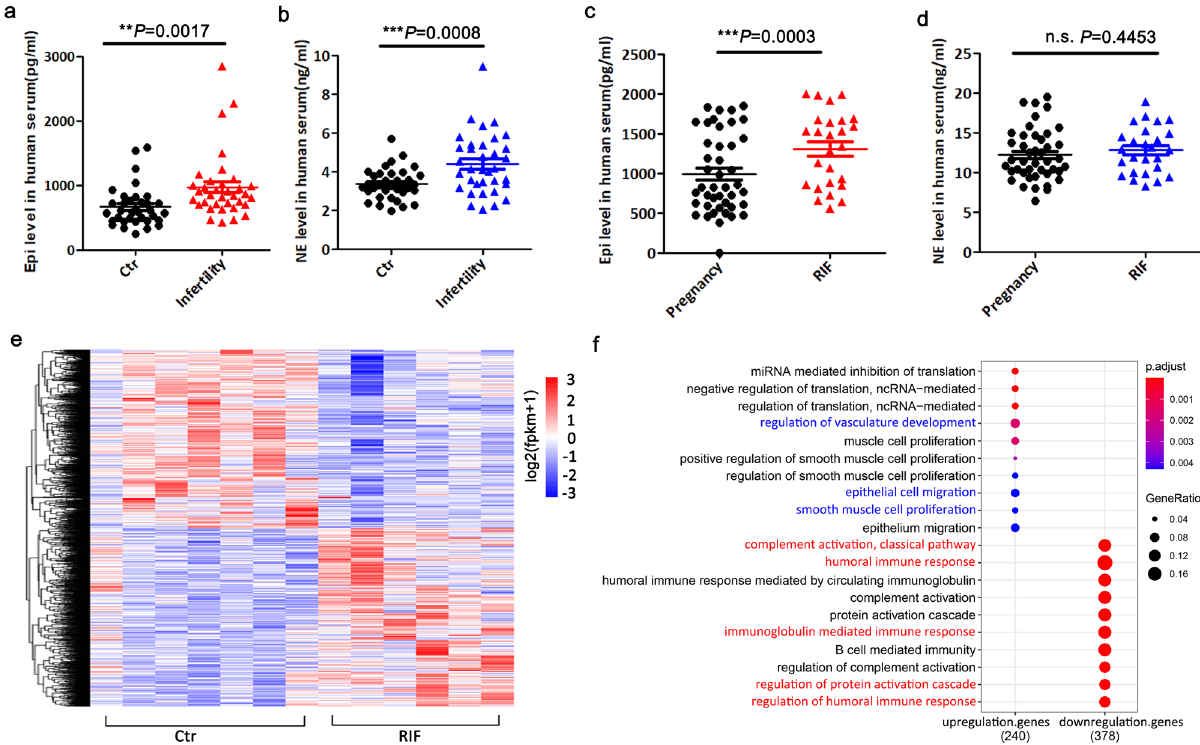
Fig. 1 The changes in serum epinephrine and norepinephrine levels and transcriptomic-wide differences for endometrium in RIF patients through RNA-seq analysis. a , b Serum epinephrine and norepinephrine levels in control patients ( n = 35) and infertility patients ( n = 35); Ctr control, Epi epinephrine, NE norepinephrine. c , d Serum epinephrine and norepinephrine levels in pregnancy patients ( n = 43) and RIF patients ( n = 26); RIF recurrent implantation failure. e Heatmap of upregulated and downregulated endometrial genes in the putitive recetivive windows in RIF compared with control (upregulated genes in red and downregulated genes in blue); 1269 genes were upregulated, 1115 genes were downregulated. Signi fi cance was indicated as -log10 p value, p value ≤ 0.05 and |log2FoldChange| ≥ 0.0. f Signi fi cantly enriched GO terms for the DEGs in receptivity endometrium with RIF (upregulated genes in red and downregulated genes in blue). Values are represented as the mean ± SEM. For statistical analysis, p values were calculated by one-way ANOVA followed by Tukey ’ s multiple comparison post hoc test. Statistical signi fi cance for all analyses were * p < 0.05; ** p < 0.01; *** p <